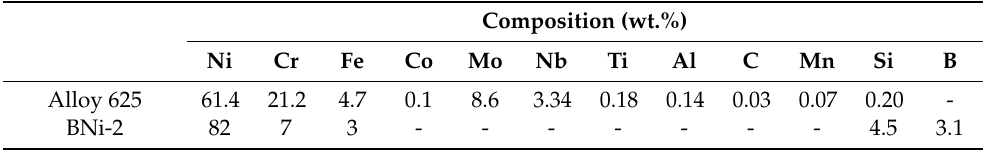
Figure 1. Geometry of the thin-tube brazed fatigue specimen. Table 1. Chemical compositions of alloy 625 and BNi-2 used in this study.